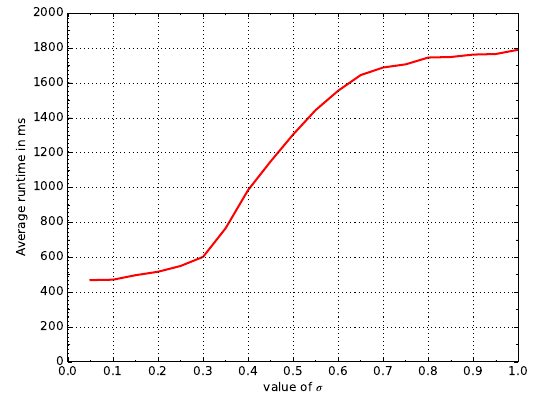
Figure 8. Influence of the value of σ on the